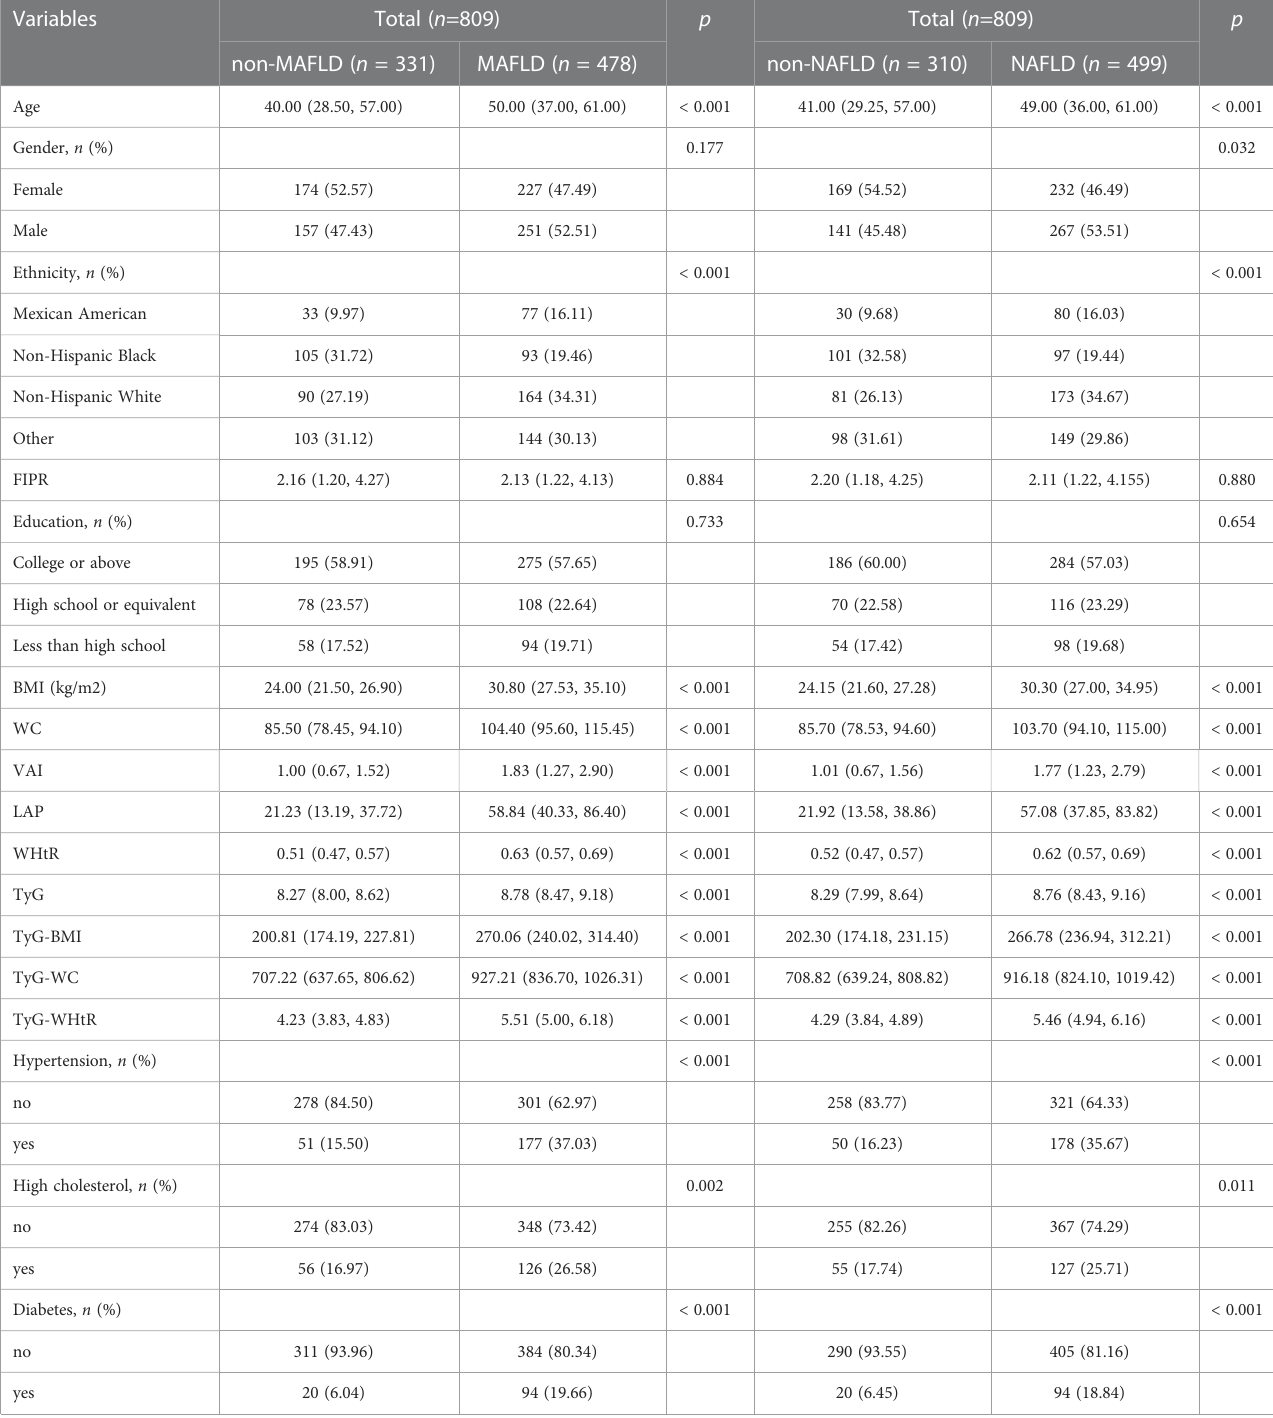
TABLE 1 Basic characteristics of participants by MAFLD and NAFLD in NHANES 2017-2018.